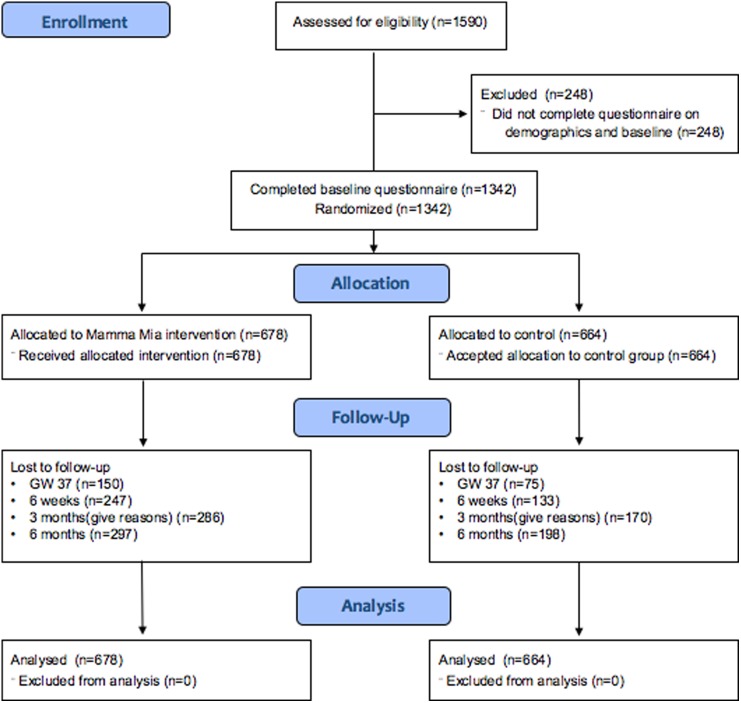
Participant flowchart.